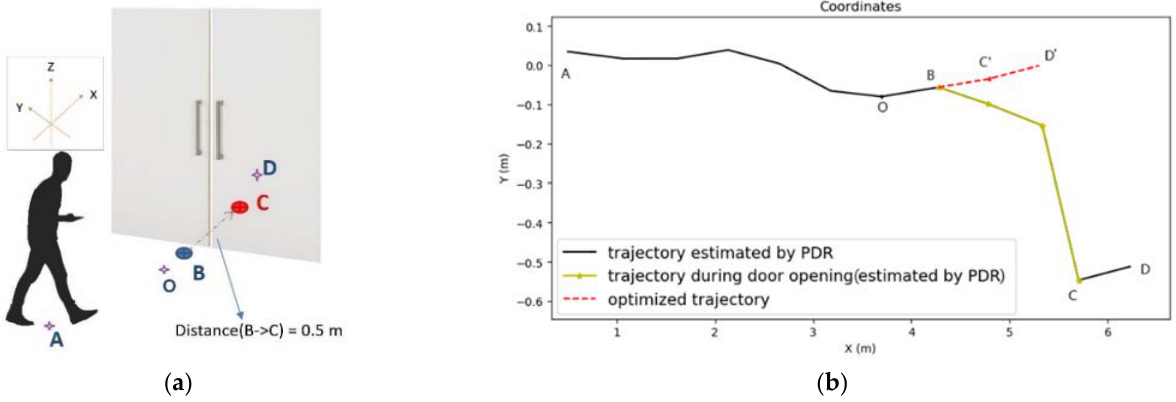
Figure 14. ( a ) The illustration of door opening trajectory. ( b ) An example of trajectory optimization during door opening.